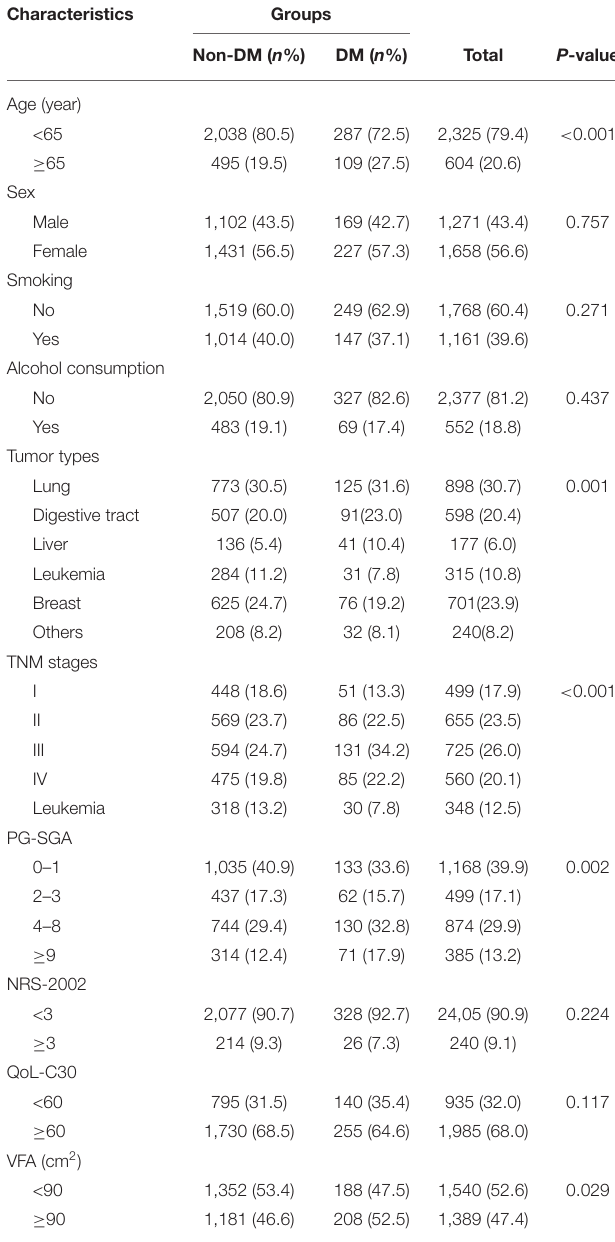
TABLE 1 | Patient characteristics stratified by